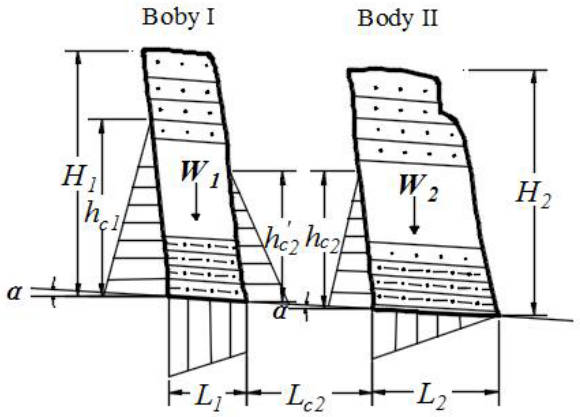
Figure 8. Geomechanical model of the two-stage plate-shaped bod- ies.